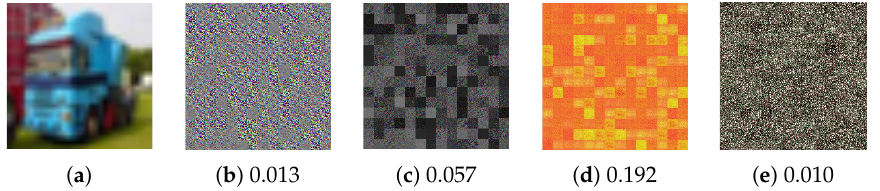
Figure 4. Example of images restored from ones encrypted by ConvMixer-Encryption. ( a ) Plain, ( b ) Encrypted, ( c ) FR-attack, ( d ) GAN-attack, ( e )